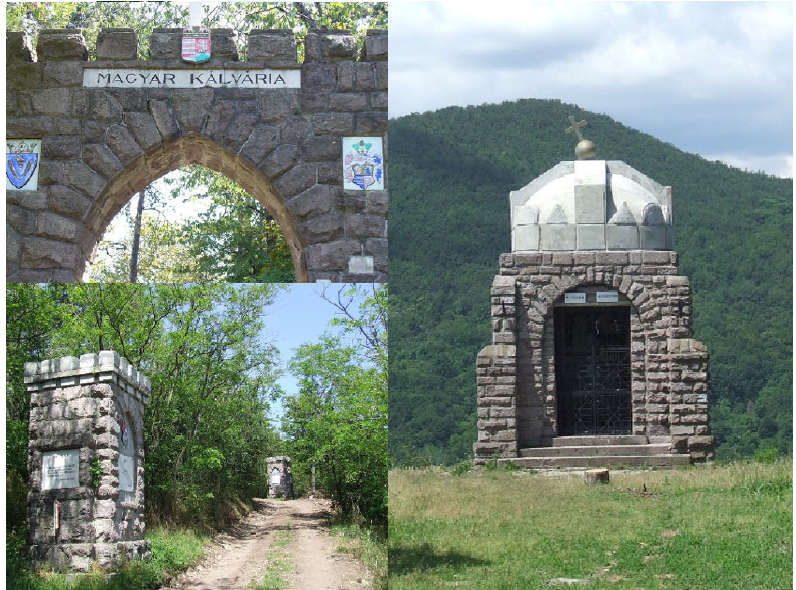
Figure 4. The so-called “Hungarian Calvary” near Sátoraljaújhely. The Calvary also has its separate “Stations” like those of the passion of Christ, and a final sanctuary—with the “Sacred Crown” on its top—at the end of the pilgrims’ path.